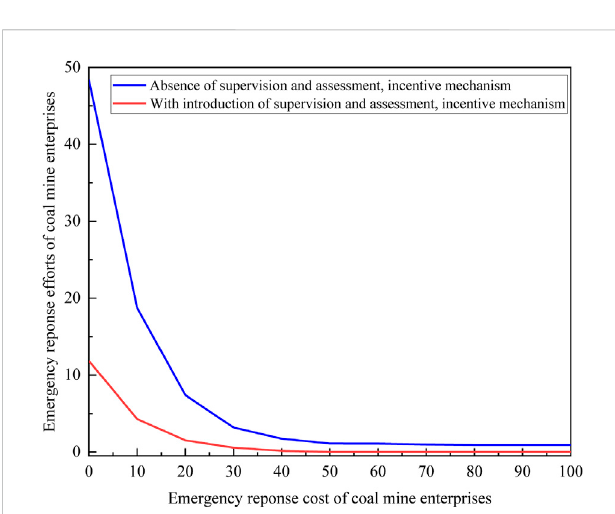
FIGURE 3 Relationship between emergency response efforts and emergency response costs of coal mine enterprises under different rewards and